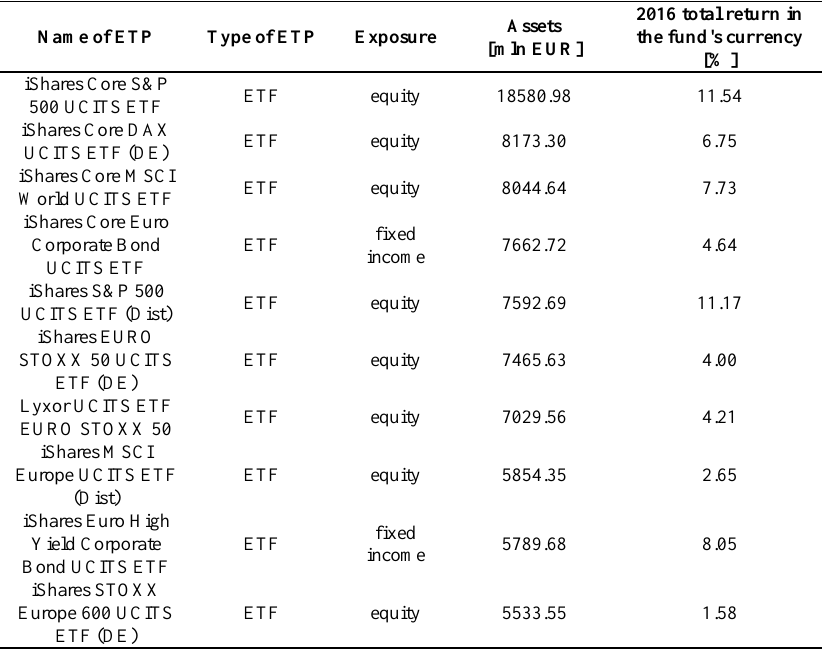
Table 2. Ten largest ETPs listed in Germany in 2016 (year-end